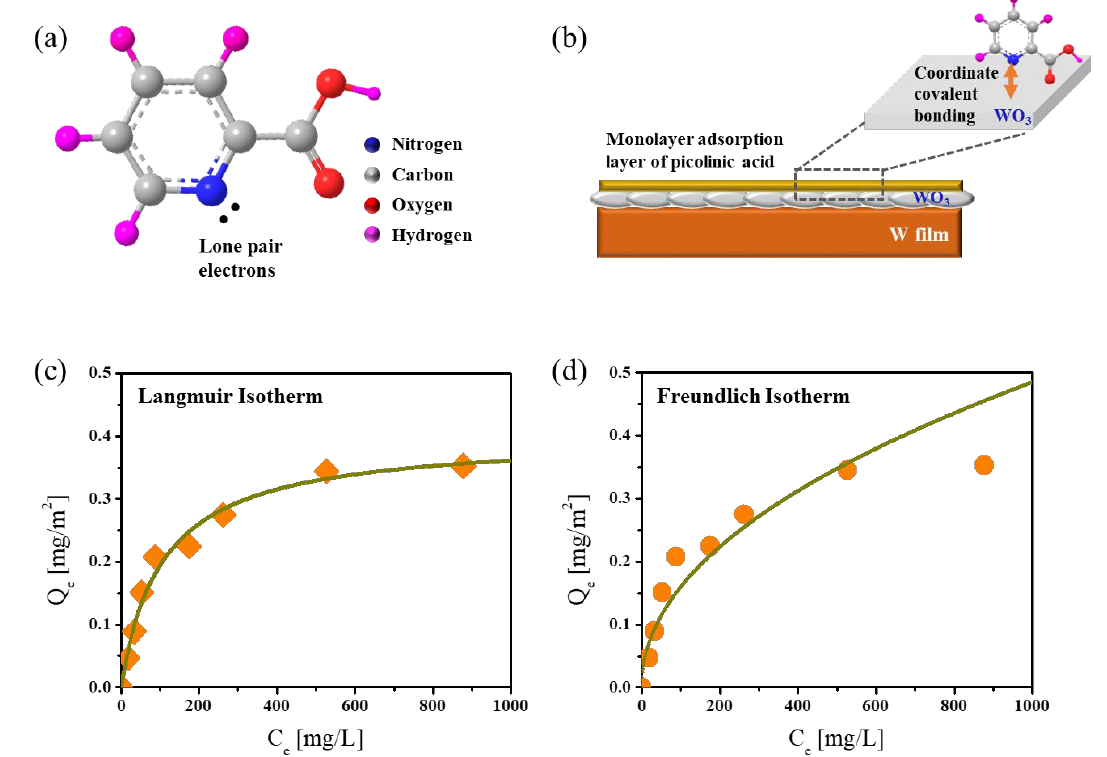
Figure 1. ( a ) Molecular structure of picolinic acid. ( b ) Schematic illustration of picolinic acid adsorp- tion onto the tungsten films. Adsorption isotherms of tungsten oxide as a function of picolinic acid concentration analyzed using ( c ) Langmuir and ( d ) Freundlich equations.